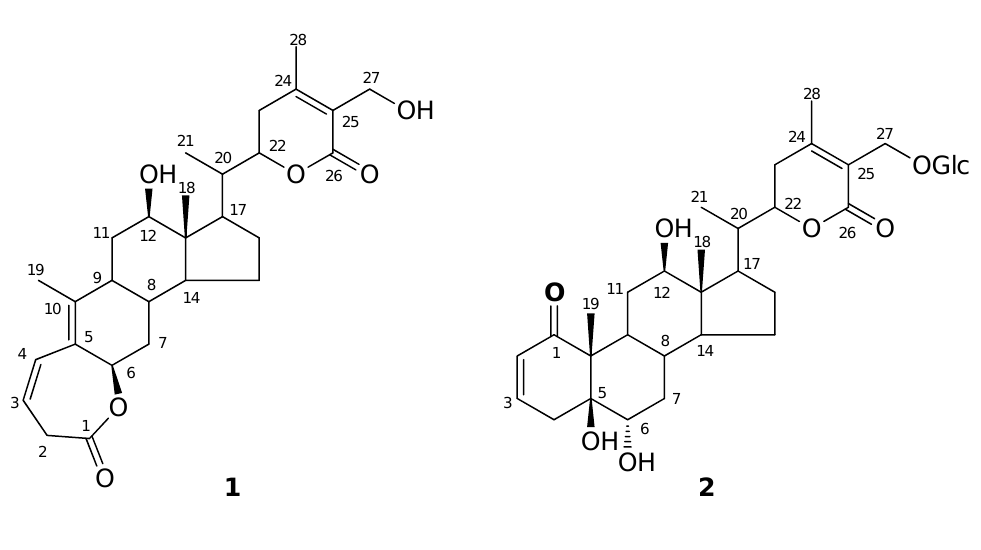
Figure 1. Structures of 1 and 2